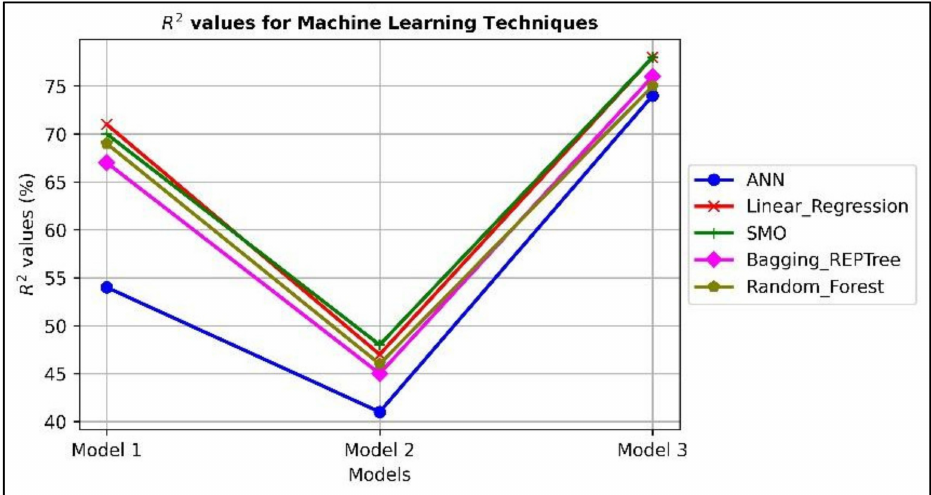
Figure 3. Machine learning techniques R 2